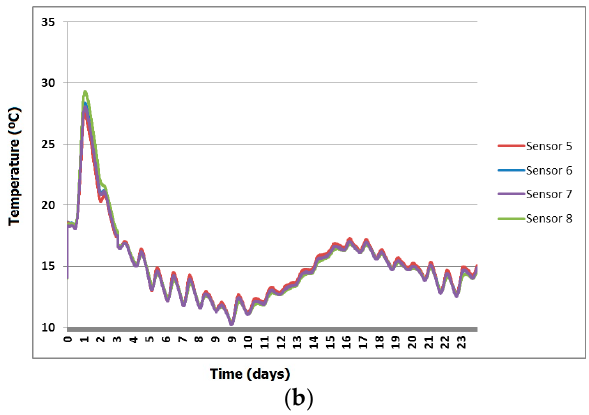
Figure 15. Temperature profile of concrete from sensors. ( a ) Sensors from 1 to 4. ( b ) Sensors from 5 to 8. Table 1. Main mechanical parameters of the employed concrete at early ages and 28 days.